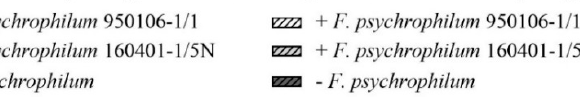
Figure 7. Exp. I, section C: phages FpV4 and FPSV-D22 in connection with the eyed eggs and in the corresponding bath/well following phage bath exposures: ( A ) phage bath no. 1 (10 9 PFU mL − 1 ) and ( B ) phage bath no. 2 (10 8 PFU mL − 1 ). In the phage bath control groups (containing either SM buffer or Milli-Q water), phages FpV4 and FPSV-D22 were not detected. After the bacterial challenge, eyed eggs were bath-exposed to phages FpV4 and FPSV-D22 for 48 h and subsequently moved to 24-well sterile plates containing sterile Milli-Q water (in light blue). Values represent the mean and standard deviation of three biological replicates, except for the bath content at 24 and 48 hpi ( n = 1). For the concentration of phages, the detection limit is indicated by red broken lines (calculated as 1 PFU was observed in only one of the triplicate spots in the undiluted egg (mean weight = 100 mg) or well sample). Unpaired t tests of log-transformed values were performed to compare the tested conditions. Statistically significant comparisons are indicated as follows: p < 0.05 (*), p < 0.001 (**), p = 0.0001 (***). F. psychrophilum 950106-1/1 and the strain 160401-1/5N were used as bacterial hosts for the phage quantification analysis according to which strain was used in the bacterial bath challenge.